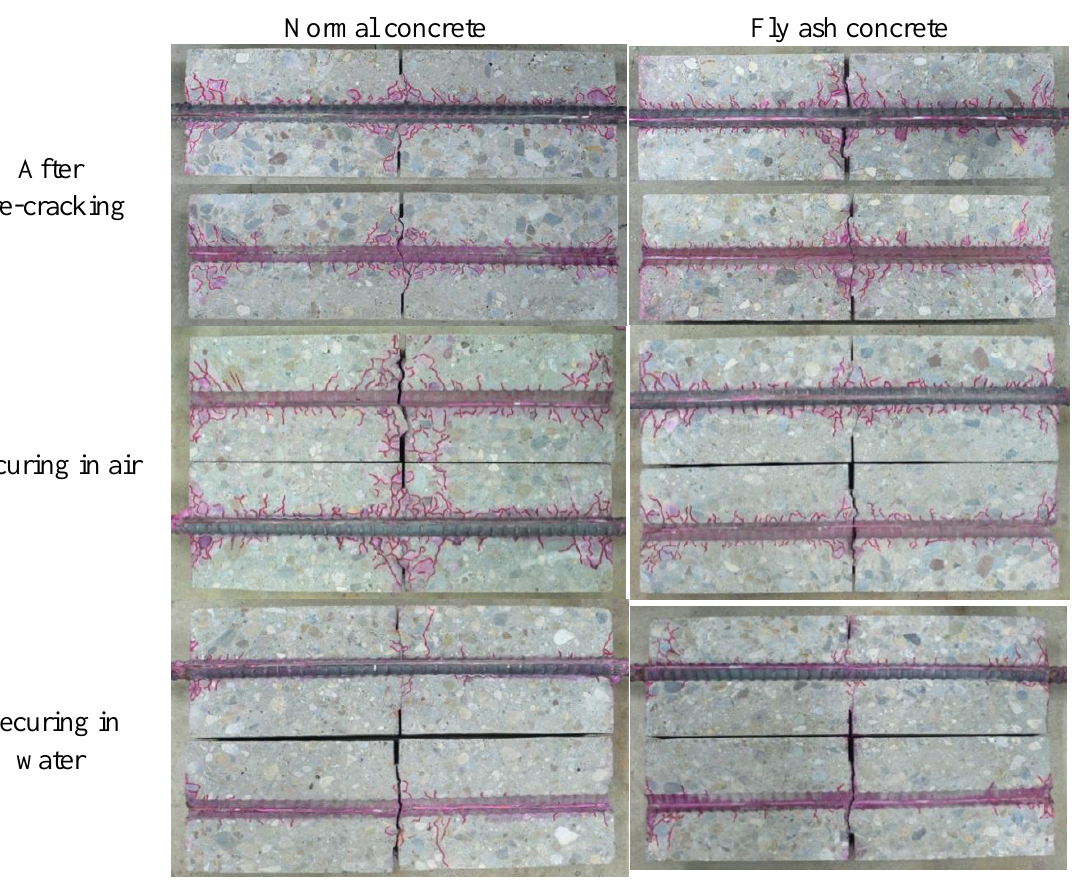
Figure 11. Observed crack